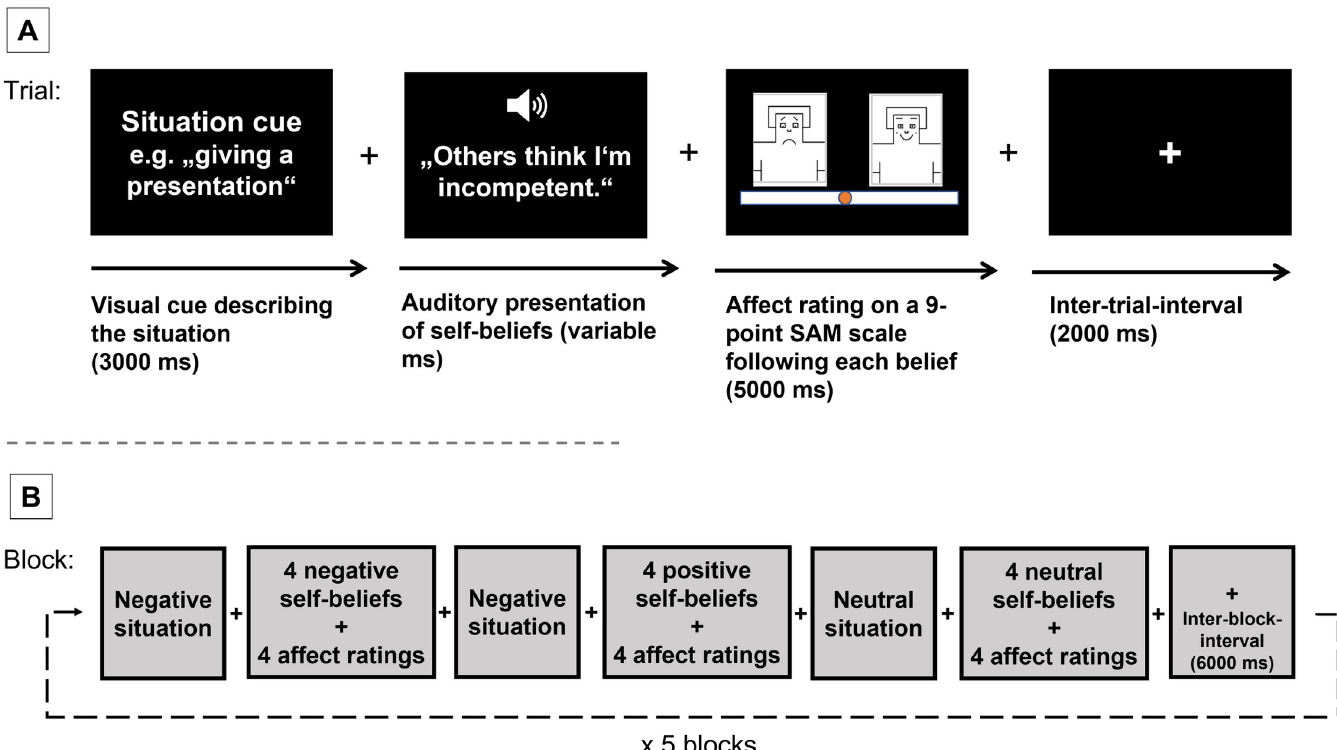
Fig 2. The self-belief task. (A) Example trial, starting with a visual cue describing an individual negative situation, next a negative self-belief was presented via loudspeakers. After listening to the self-belief, participants rated their affective response on a 9-point SAM scale. Each trial ended with a fixation cross. (B) The setup of a block. Each block started with a negative situation cue, followed by four negative self-beliefs. Next, the same negative situation cue was followed by four positive self- beliefs. Finally, a visual cue of a neutral situation and four neutral self-beliefs were presented. Participants rated their affective response after each belief. Each block ended with a fixation cross. In total, there were five blocks, using five negative and five neutral situations.